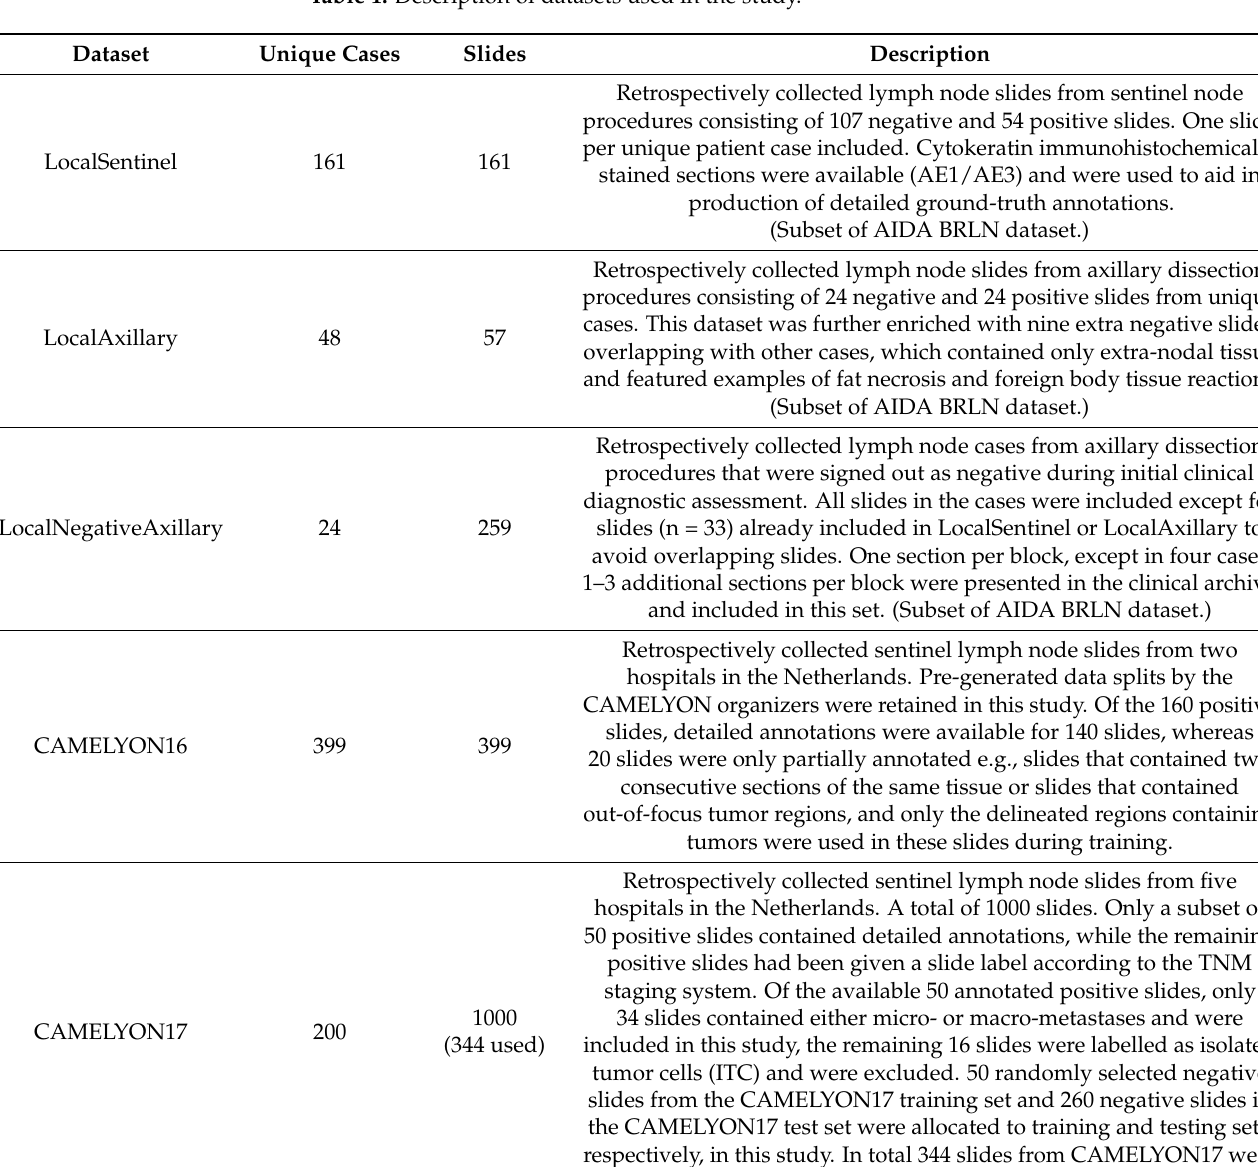
Table 1. Description of datasets used in the study.